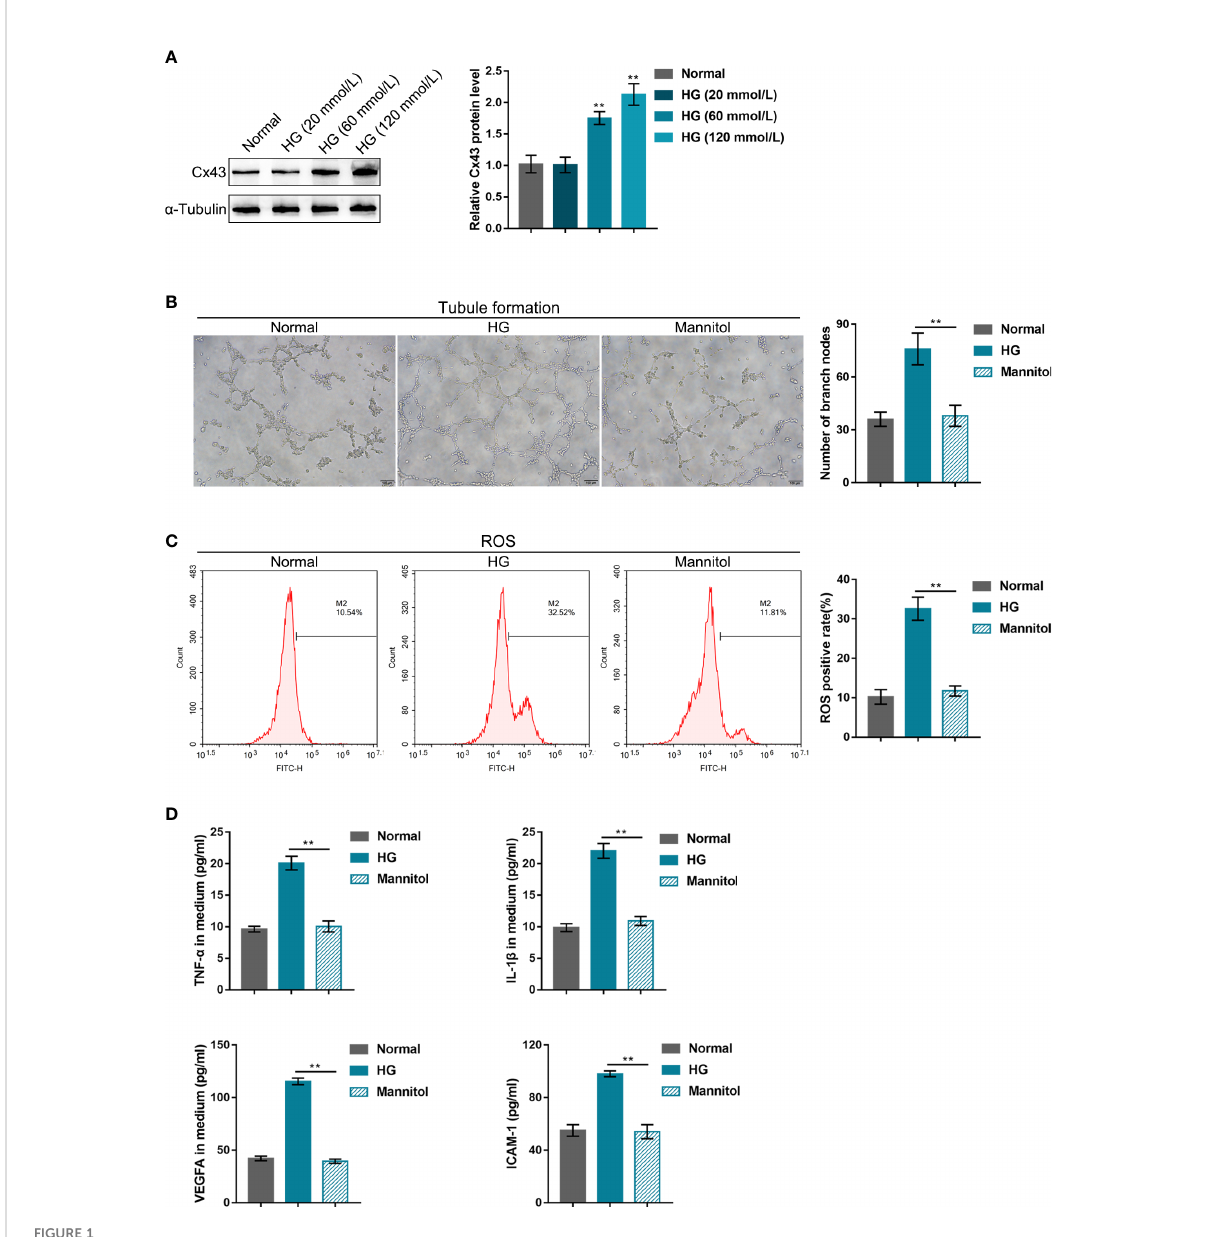
FIGURE 1 High-glucose (HG) impairs human retinal endothelial cell functions (A) hRECs were stimulated with gradient concentrations of glucose (20, 60, or 120 mmol/L) and examined for connexin 43 (Cx43) protein level using Immunoblotting. hRECs were subsequently stimulated with HG (60 mmol/L) or mannitol (60 mmol, to exclude the osmotic effect) and examined for tubule formation on Matrigel (B) ; ROS release using fl ow cytometry (C) ; the content of tumor necrosis factor alpha (TNF- a ), interleukin-1 b (IL-1 b ), vascular endothelial growth factor A (VEGFA), and intercellular adhesion molecule 1 (ICAM-1) in culture medium using ELISA kits (D) . n = 3, **p<0.01 compared with the normal